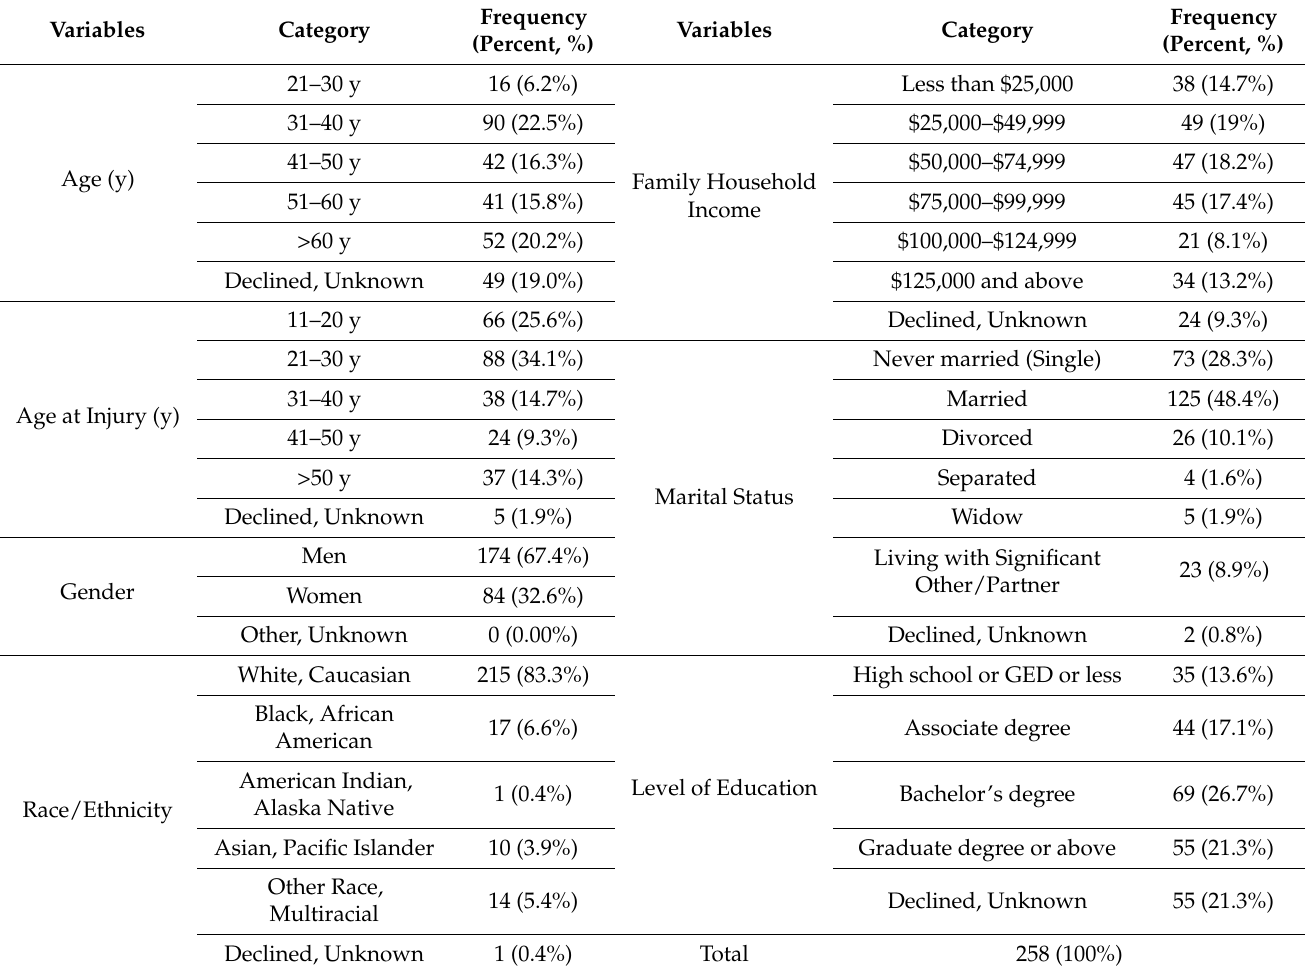
Table 4. Demographic and Injury Characteristics of Quantitative Research Sample.